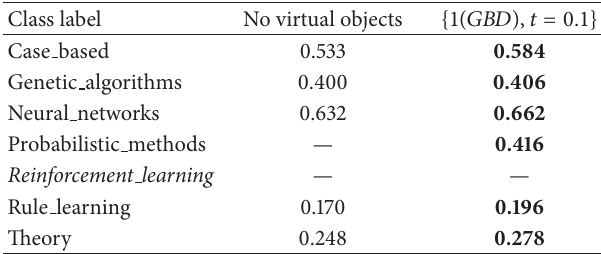
Table 7: Comparison of recognition rates with and without virtual objects ( Cora -test).